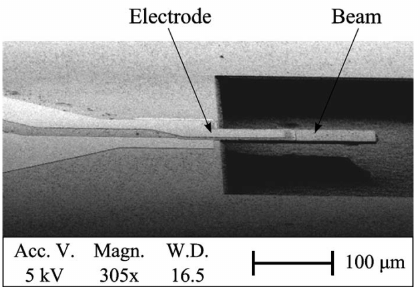
Figure 14. SEM image of a SiC cantilever resonator with a PZT actuating electrode [48]. Reprinted with permission from J. Vac. Sci. Technol. B, 28, Mastropaolo et al., Piezoelectrically driven silicon carbide resonators, c (cid:13) 2009, American Vacuum